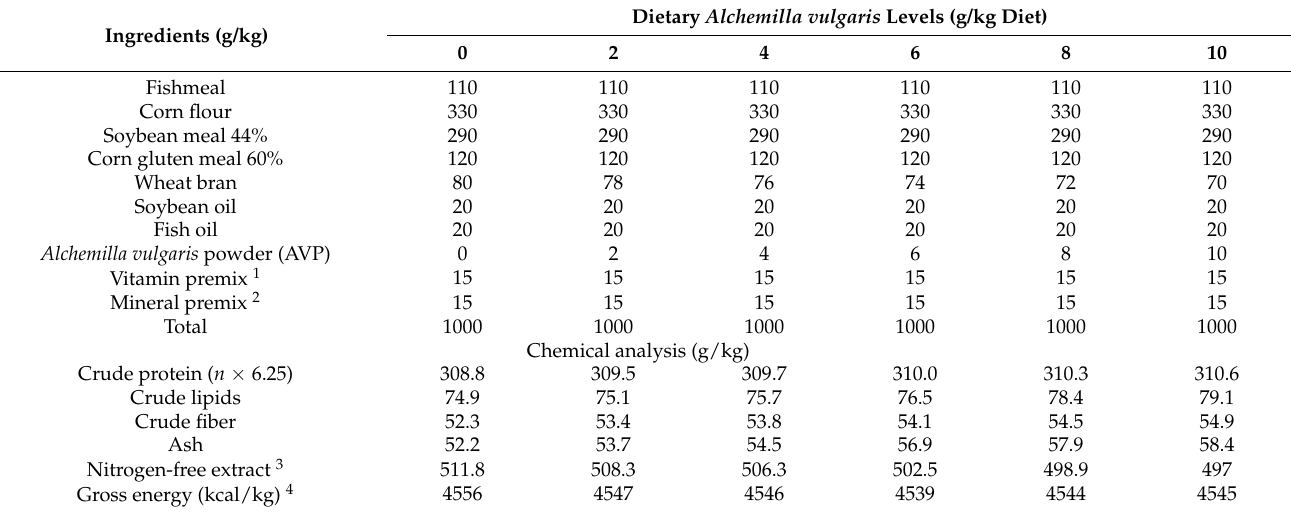
Table 1. Ingredients and proximate chemical analysis of the experimental diets